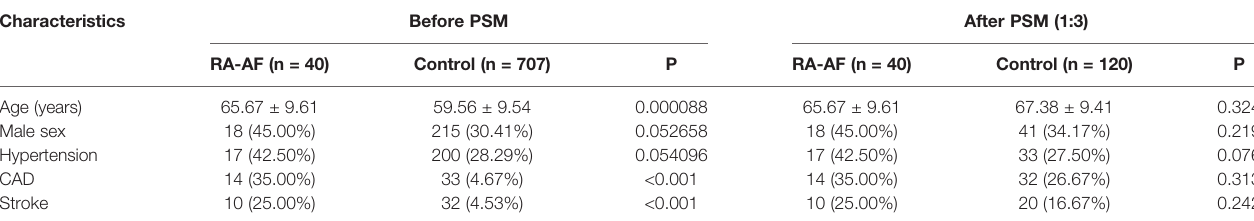
TABLE 1 | Baseline characteristics of patients with RA (control) and with RA and AF. Characteristics